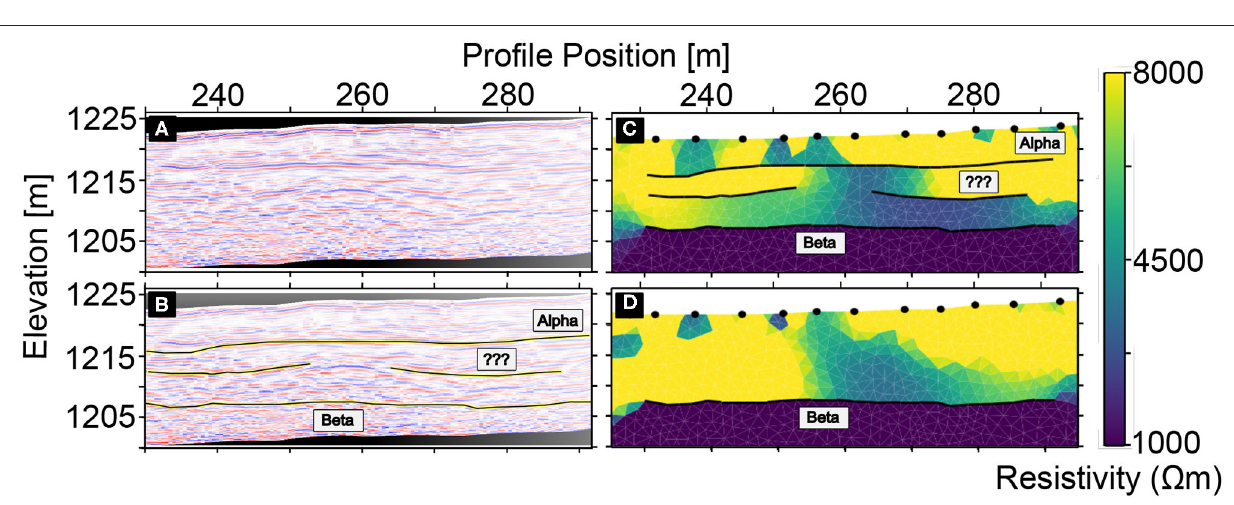
Frontiers in Earth Science |